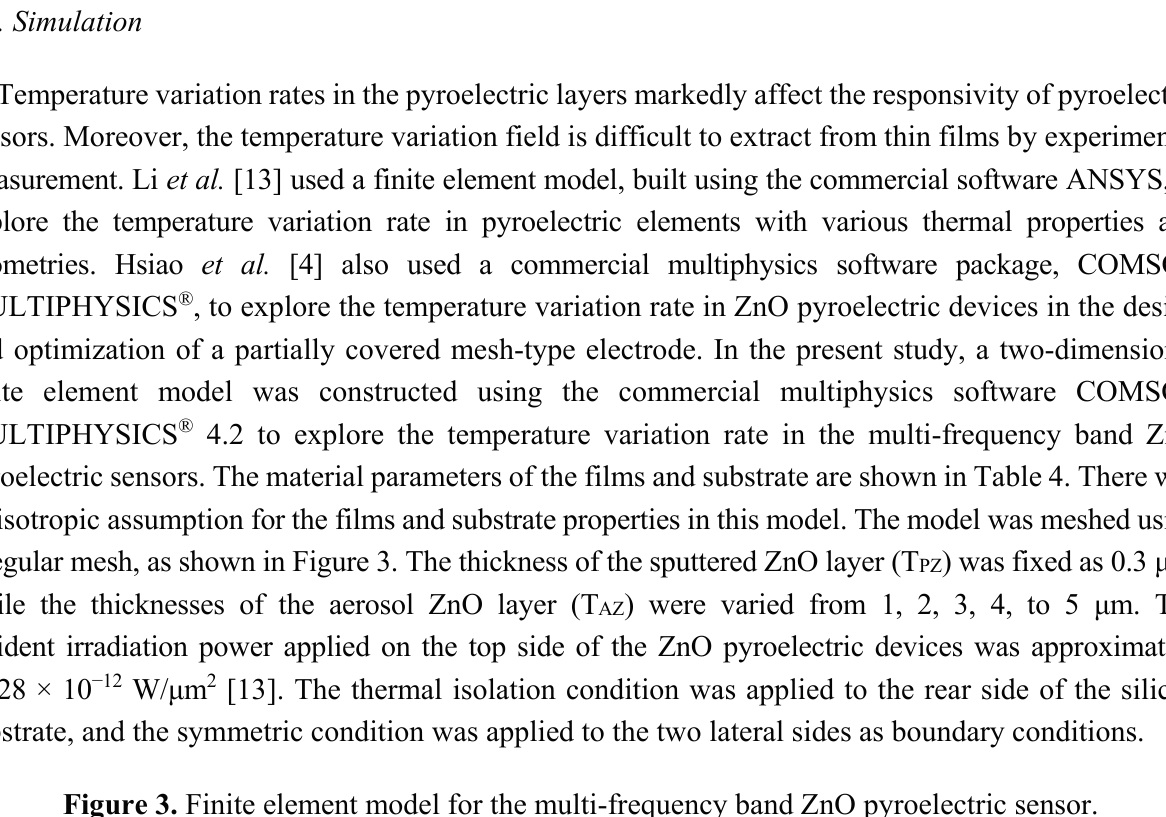
Figure 3. Finite element model for the multi-frequency band ZnO pyroelectric